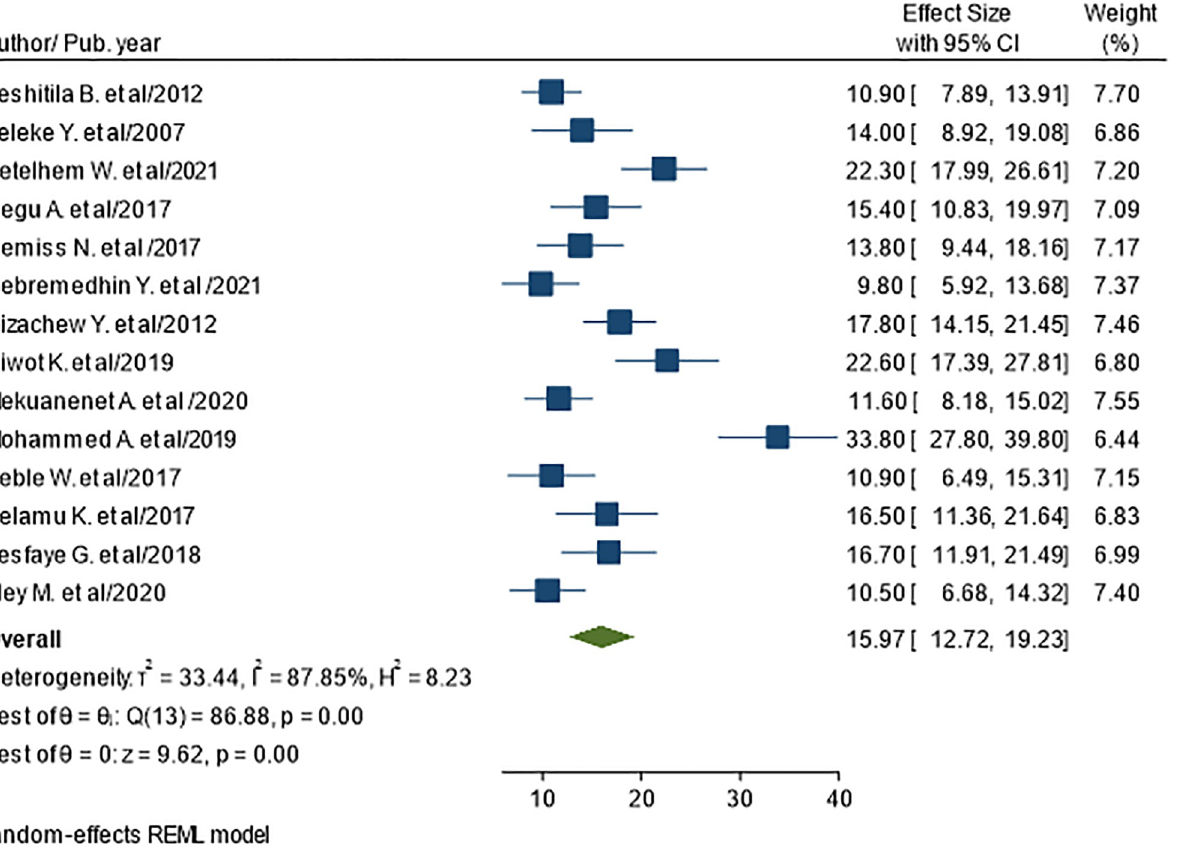
Fig 2. The pooled prevalence of UTI among diabetic populations in